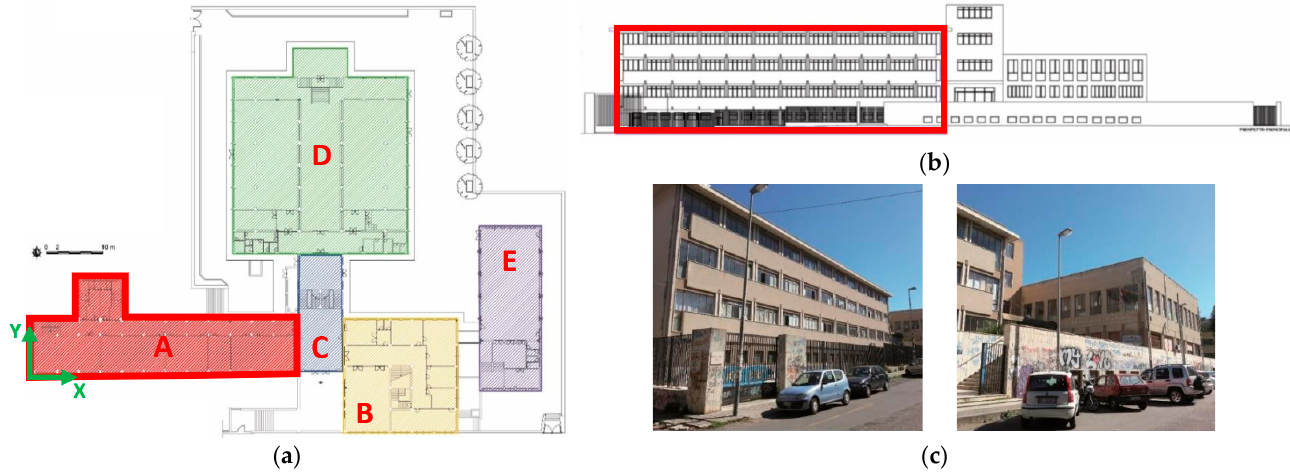
Figure 4. Frangipane School in Reggio Calabria: ( a ) top view and ( b ) front view (South side), with evidence (red box) of the area of retrofit intervention, and ( c ) outside view.